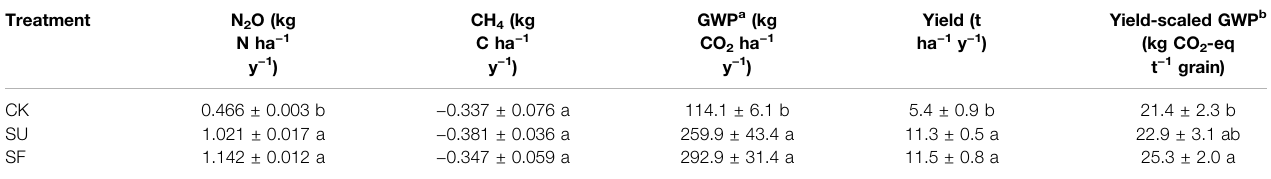
TABLE 3| MeanannualCH 4 andN 2 Oemissions andtheirestimated global warmingpotentials(GWP), yield,and yield-scaled GWPoversixannualcycles fromMay2010to April 2016. Treatment